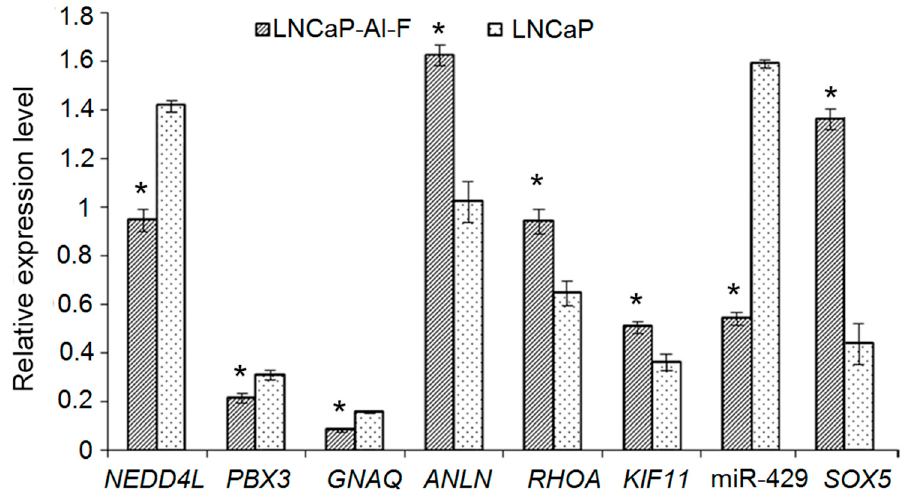
Figure 5. Relative mRNA expression levels of MDEGs and miR-429 determined by quantitative real-time PCR. The expression levels of genes were normalized against glyceraldehyde-3-phosphate dehydrogenase, and the expression level of miR-429 was normalized against U6 small nuclear RNA. *, p < 0.05. MDEGs: differentially expressed genes that overlapped with differentially methylated regions.